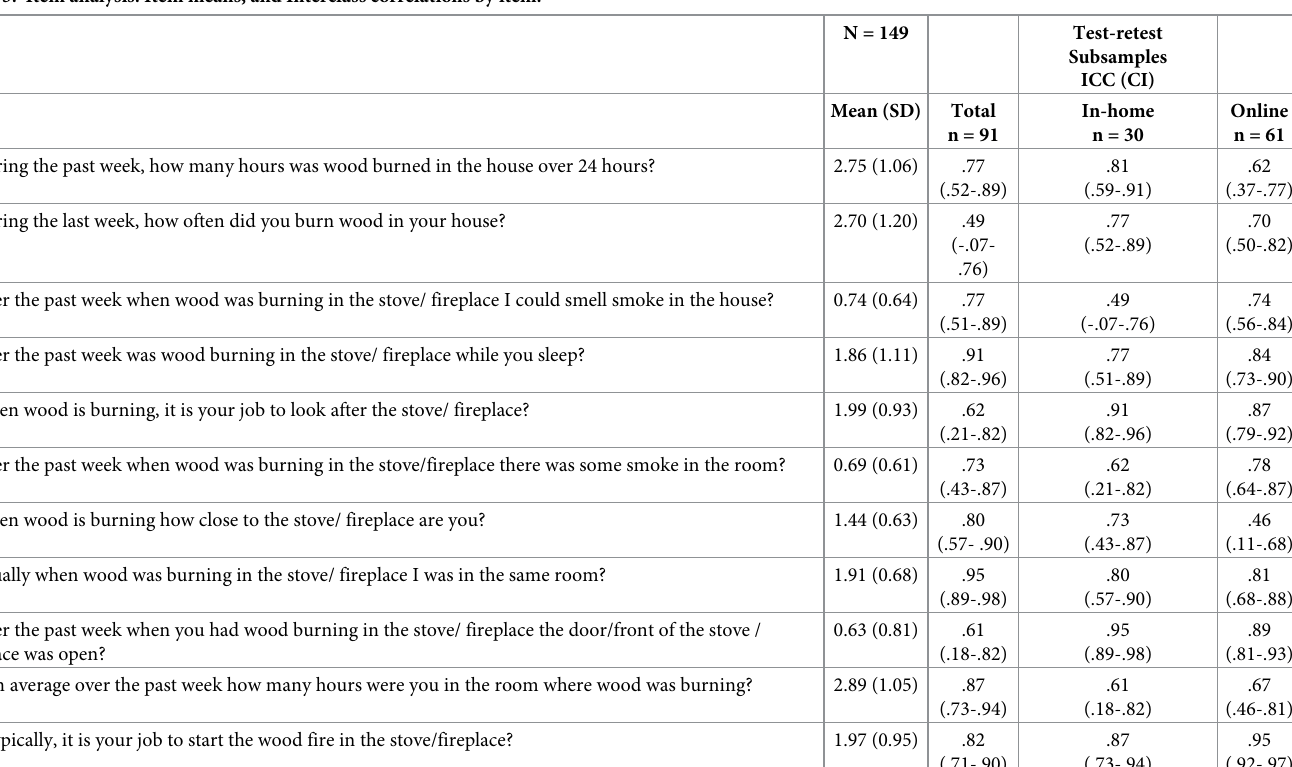
Table 3. Item analysis: Item means, and Interclass correlations by item.